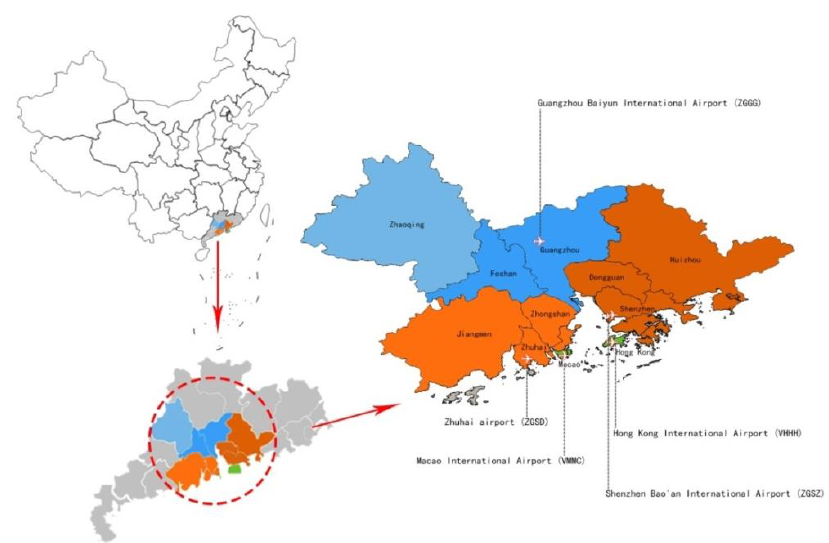
Figure 1. Study area and the locations of the five airports.